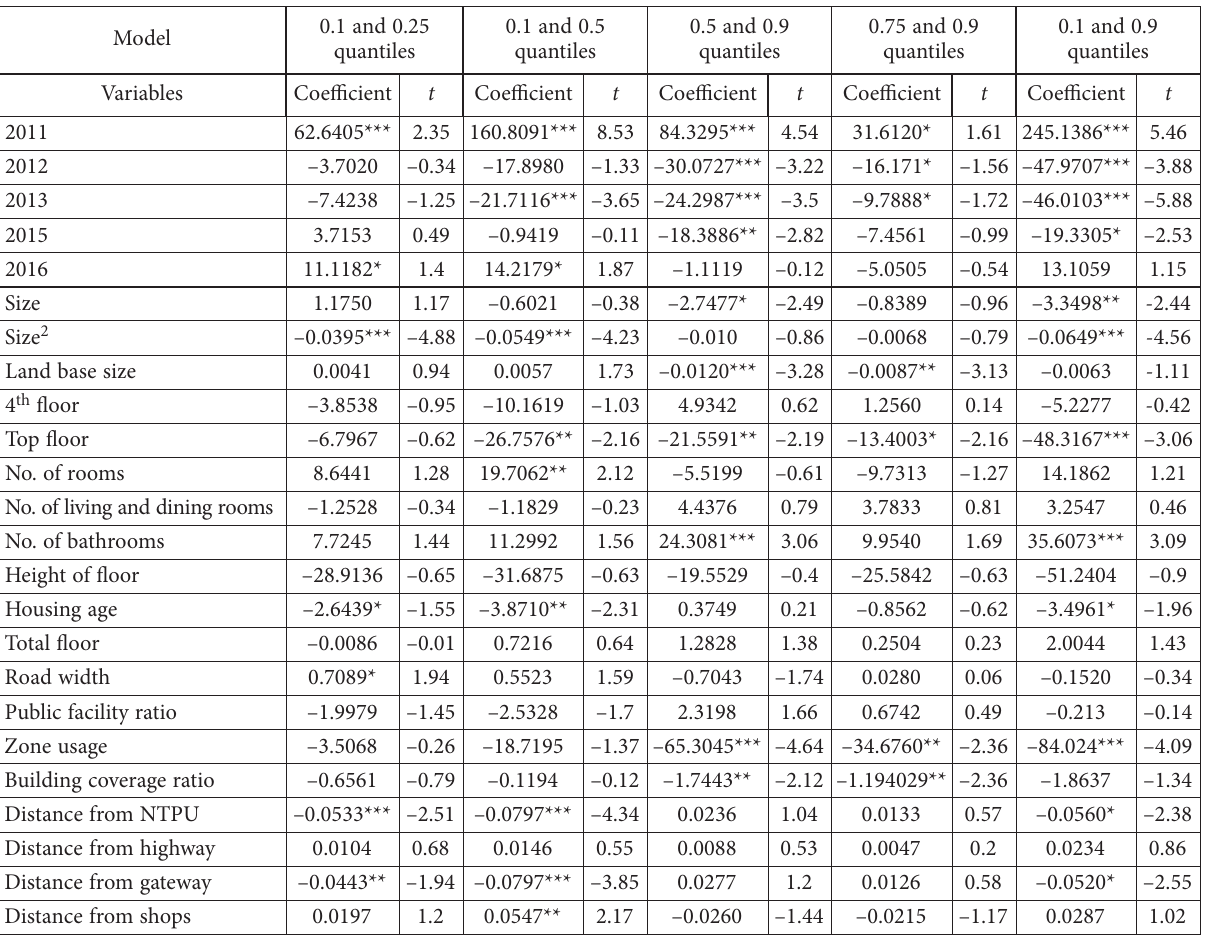
Table 4. Housing total price model – coefficient difference test results for different